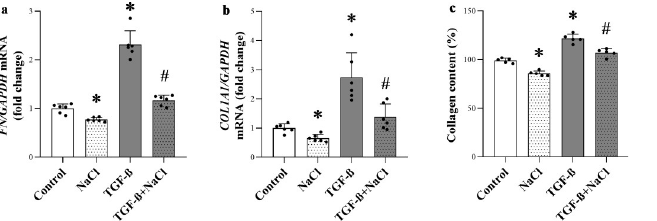
Fig 5. Effect of high NaCl concentration on the ECM marker production of human primary dermal fibroblasts. ( a-b) The mRNA expression of FN and COL1A1 in the human dermal fibroblasts was determined by real-time PCR in comparison with GAPDH . ( c ) The proportion of collagen content in human DFs was detected by SiriusRed collagen detection assay. Data were normalized and presented as the ratio of the mean values of the control group. Values were expressed as mean+SD (n = 6 in each group); � p < 0.05 vs. Control; # p < 0.05 vs. TGF-ß; (Unpaired t-test (b,c), Mann- Whitney U-test (a)).